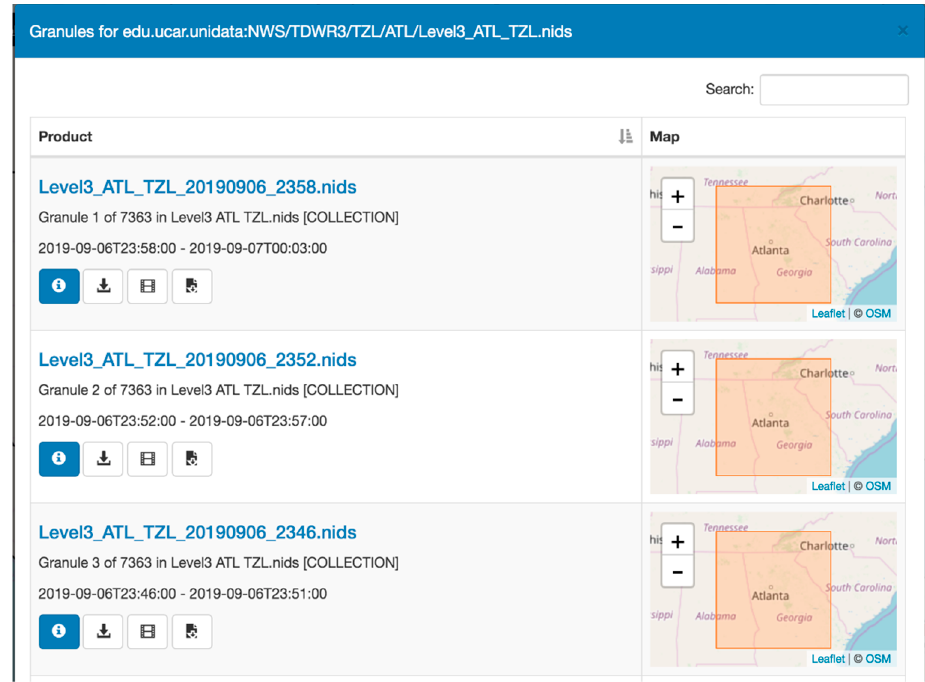
Figure 12. Search results with “List Granules” button. ISPRS Int. J. Geo-Inf. 2019 , 8 , x FOR PEER REVIEW